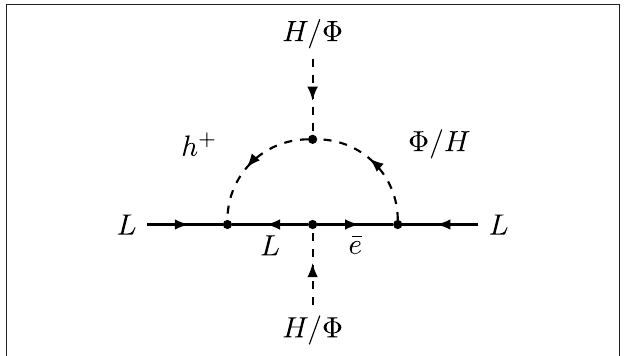
FIGURE 17 | 1-loop neutrino masses generated in the Zee model in the flavor basis.